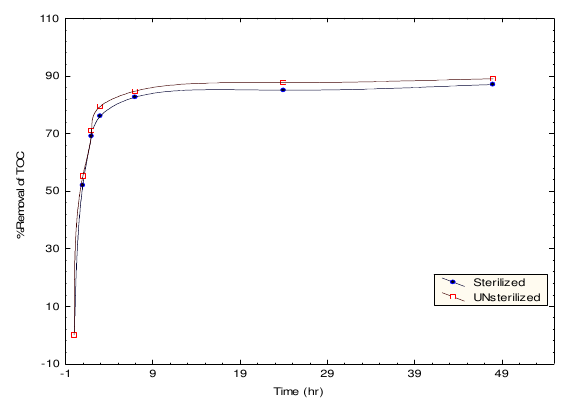
Fig. 9. Effect of sterilization on Removal percent of COD pollutant with time at T = 25 o C, pH 7, wastewater/(Algae broth) ratio = 1.